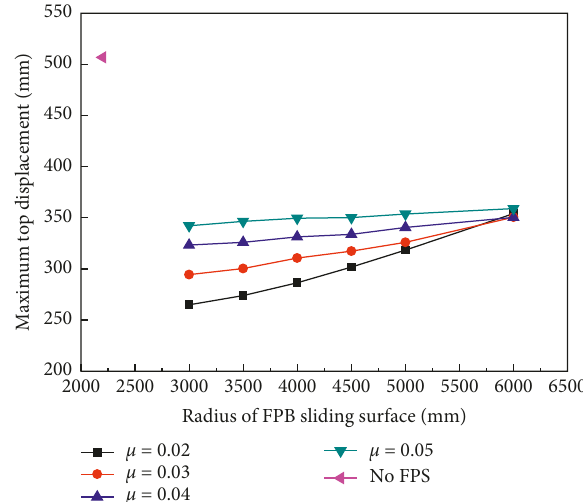
Figure 18: The maximum top displacement of T2 tower with R and μ in the Y direction under L0223S wave.